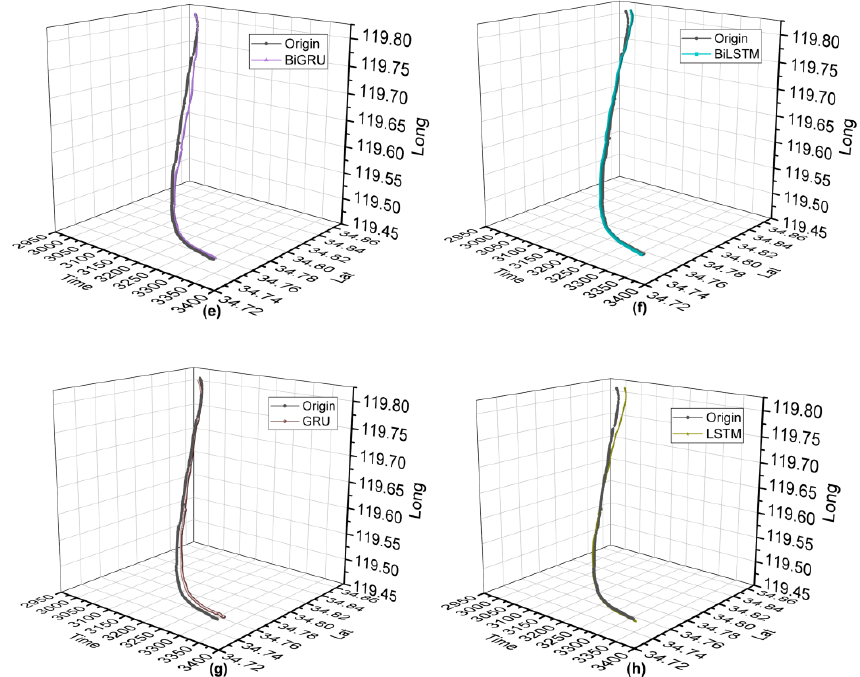
Figure 10. Ship behavior prediction: ( a ) MHA-BiGRU ( b ) MHA-BiLSTM ( c ) MHA-GRU ( d ) MHA-